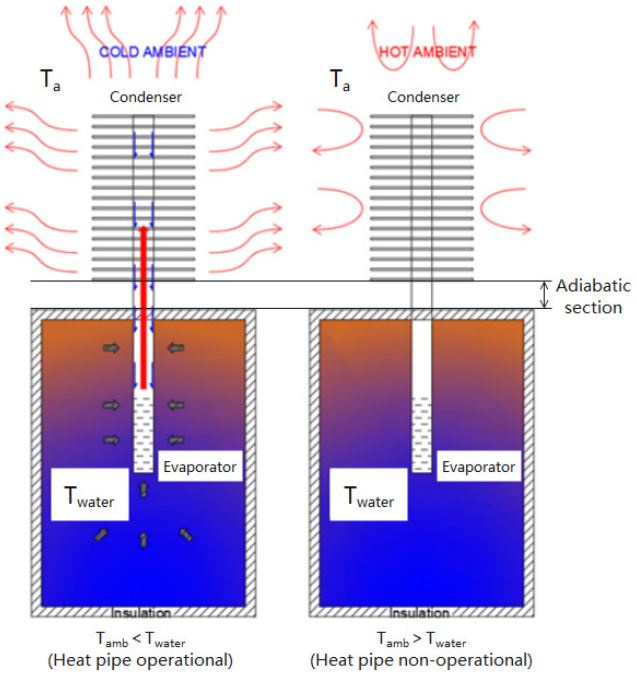
Figure 2. TDT working diagram.